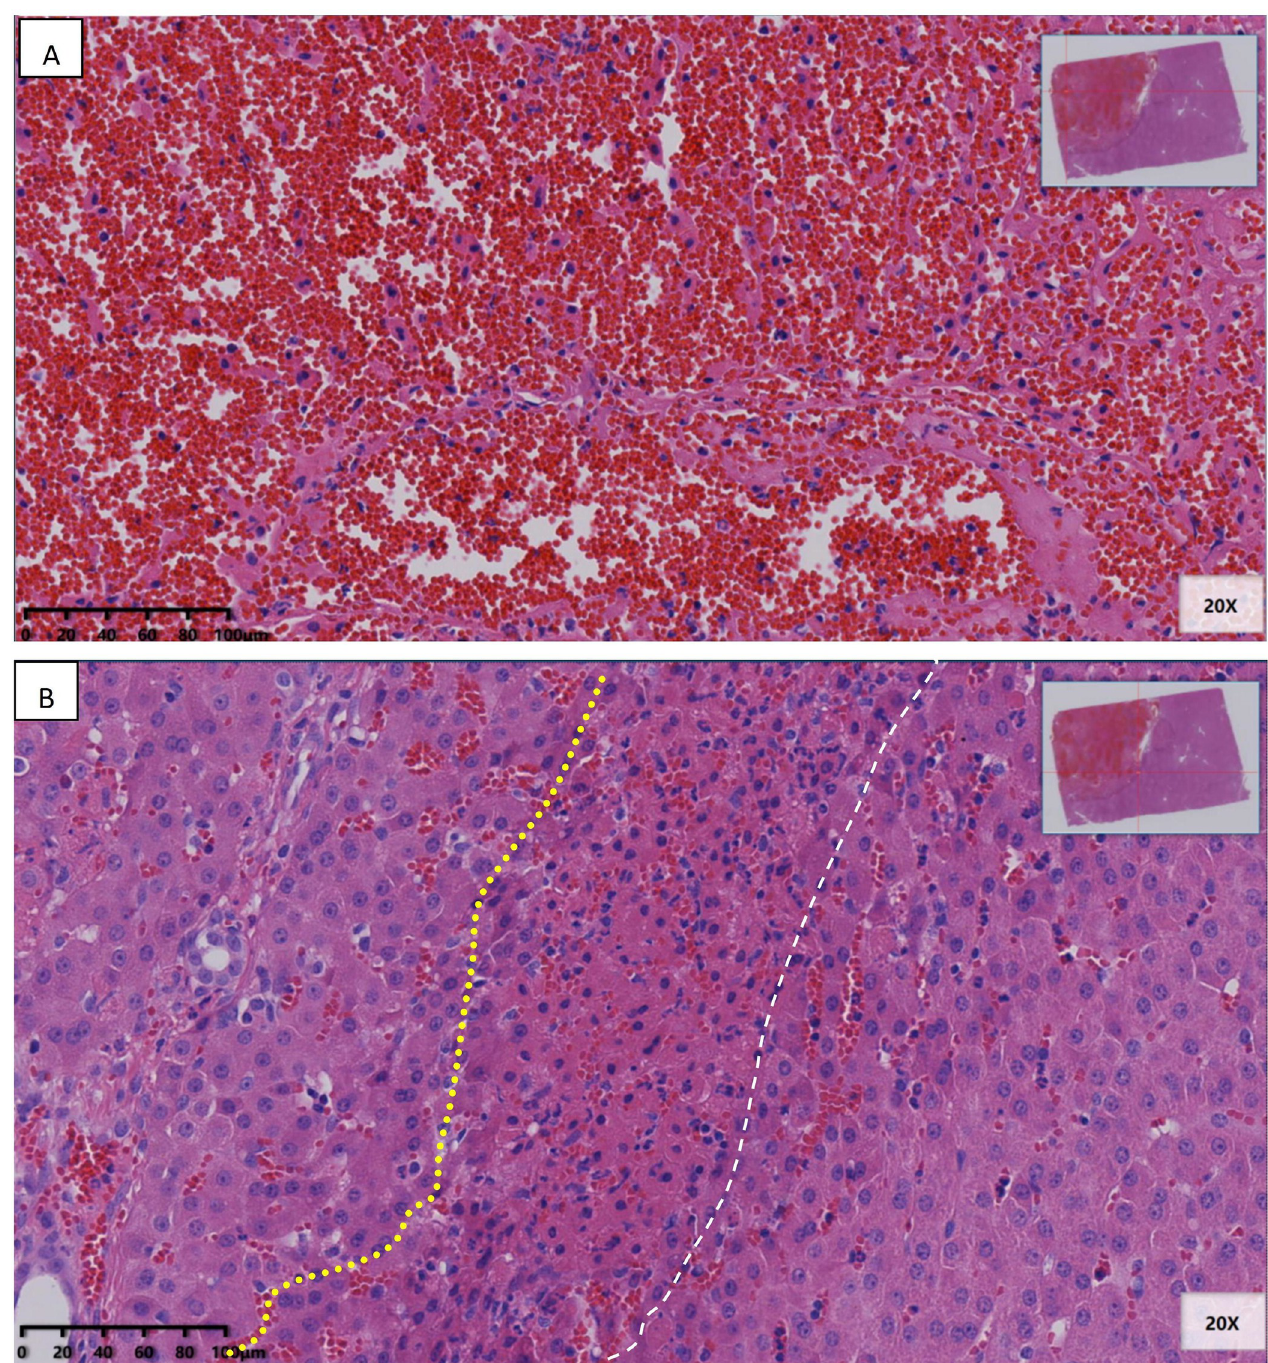
Fig 5. Liver margin and liver core treated with cryoablation